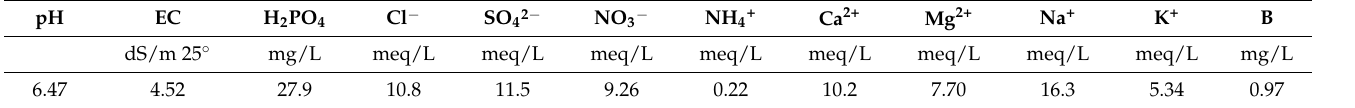
Table 2. Soil mineral